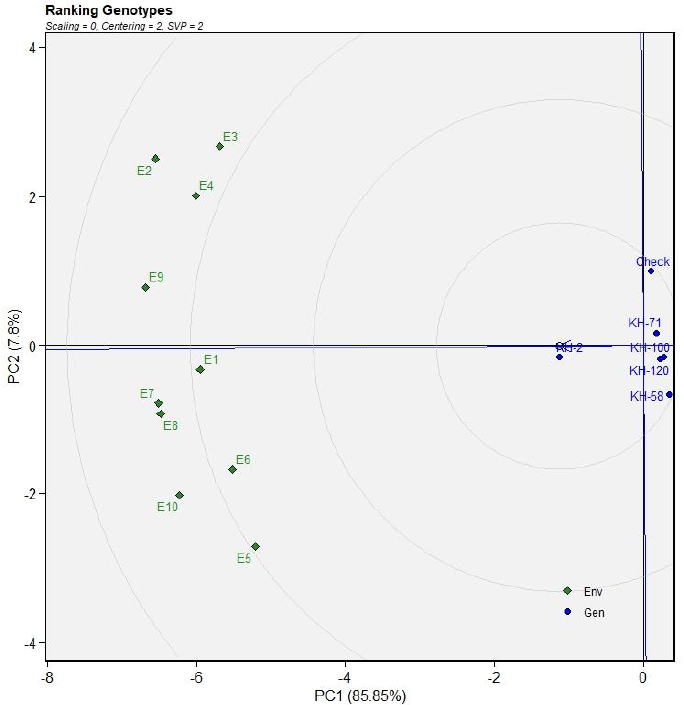
Figure 3. The genotype ranking through GGE plots for dry rhizome yield based on ideal genotype for eleven environments.